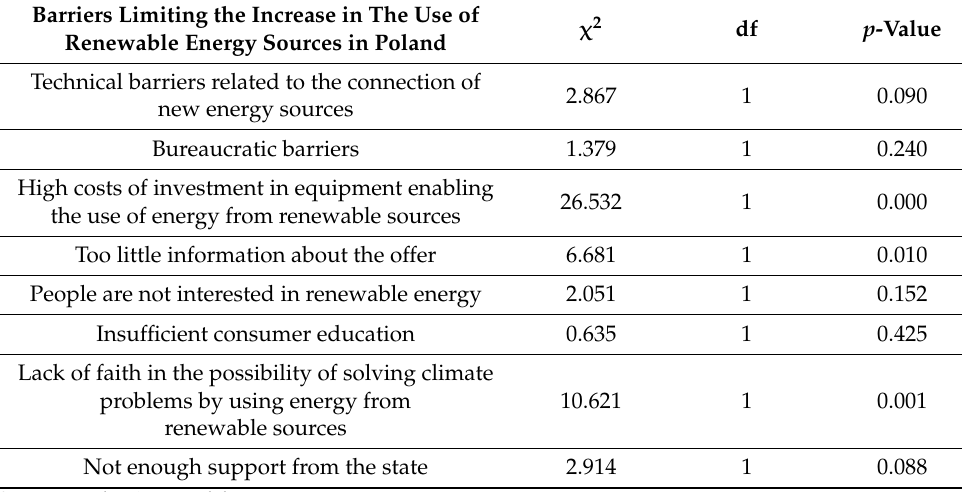
Table 3. Perception of barriers limiting the increase in the use of renewable energy sources in Poland and the use of photovoltaic